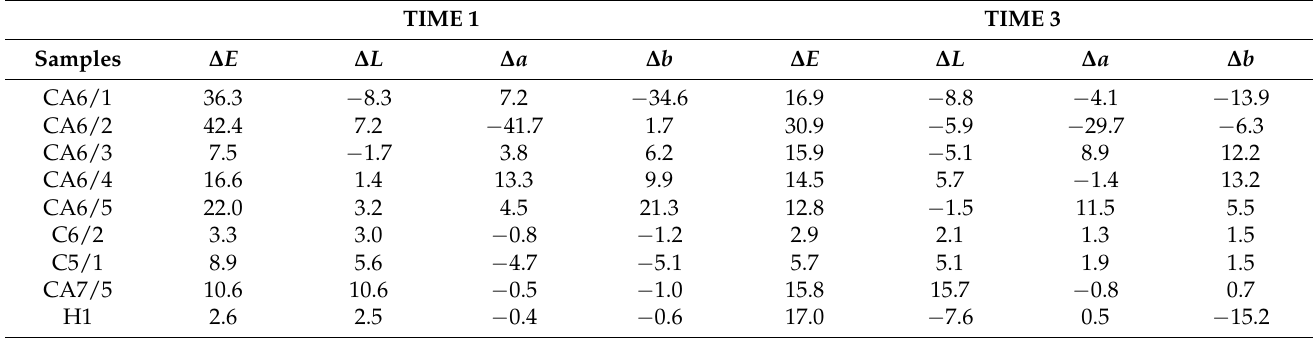
Table 5. CIEL lab color differences (D65/2 ◦ ) between glitter before and after the soaking in